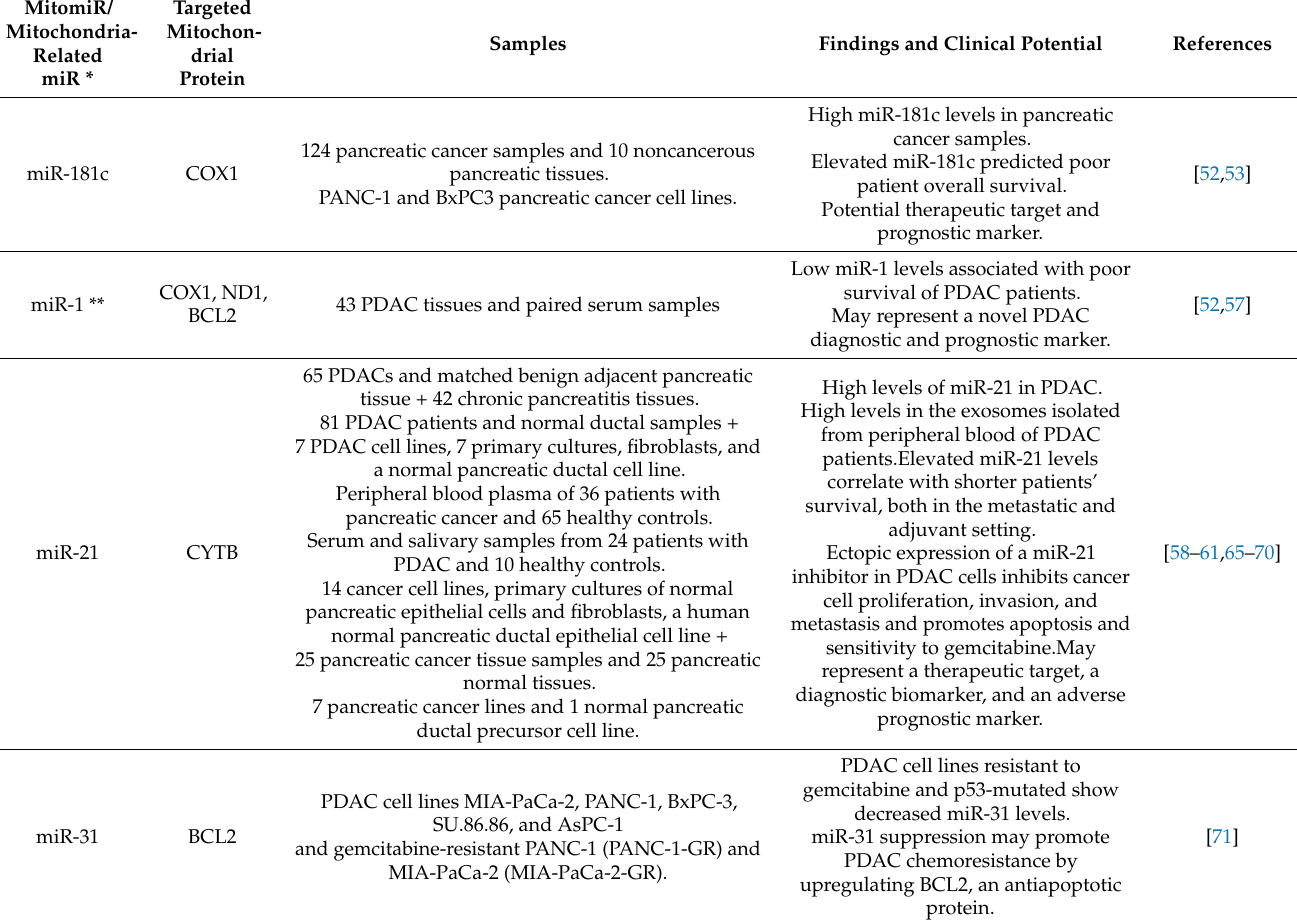
Table 2. MitomiR and mitochondria-related miR changes in pancreatic cancer and their clinical significance. Targeted MitomiR/ Mitochon- Mitochondria- drial Related Protein miR *